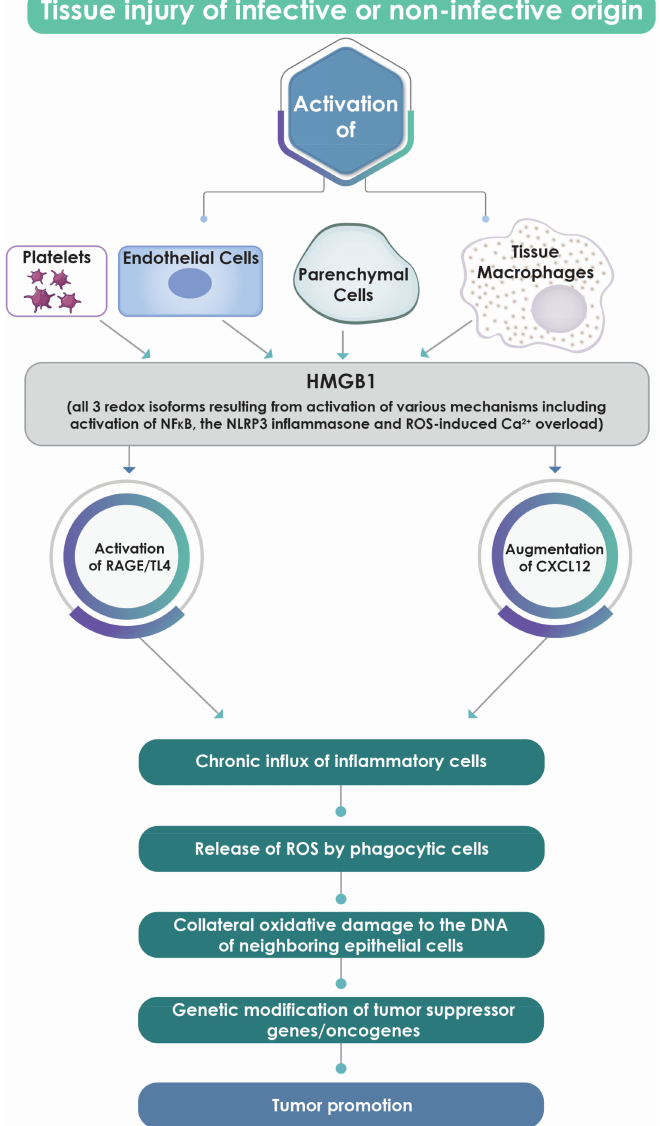
Figure 3. Summary of events by which HMGB1 derived from endothelial cells, tissue macrophages and parenchymal cells at sites of chronic tissue injury may drive a chronic inflammatory response that potentially leads to the development of epithelial cell injury, oxidative / inflammatory damage to DNA and tumor